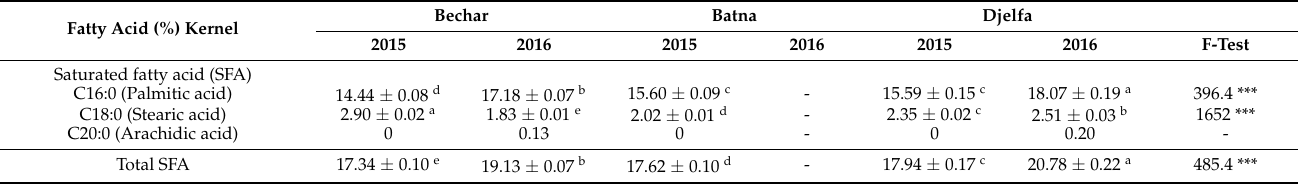
Table 3. Fatty Acid (%) Composition of the Kernel of Atlas Pistachio in Three Geographic Zones in Algeria for Two Years